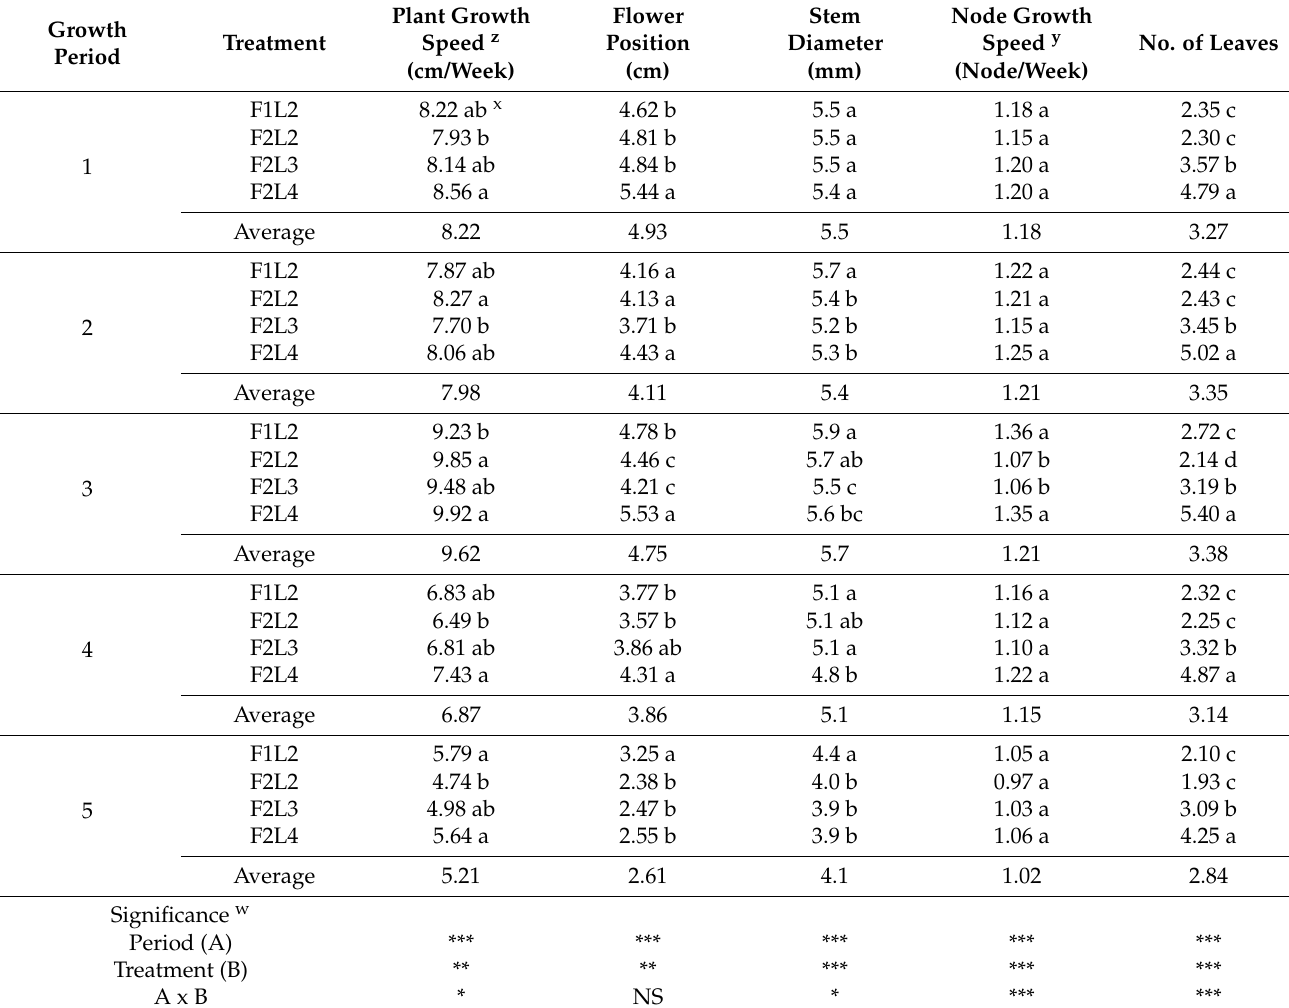
Table 1. Effect of side leaves and flowers on growth characteristics by growth period of winter-planted and summer- cultivated paprika ‘Redwing